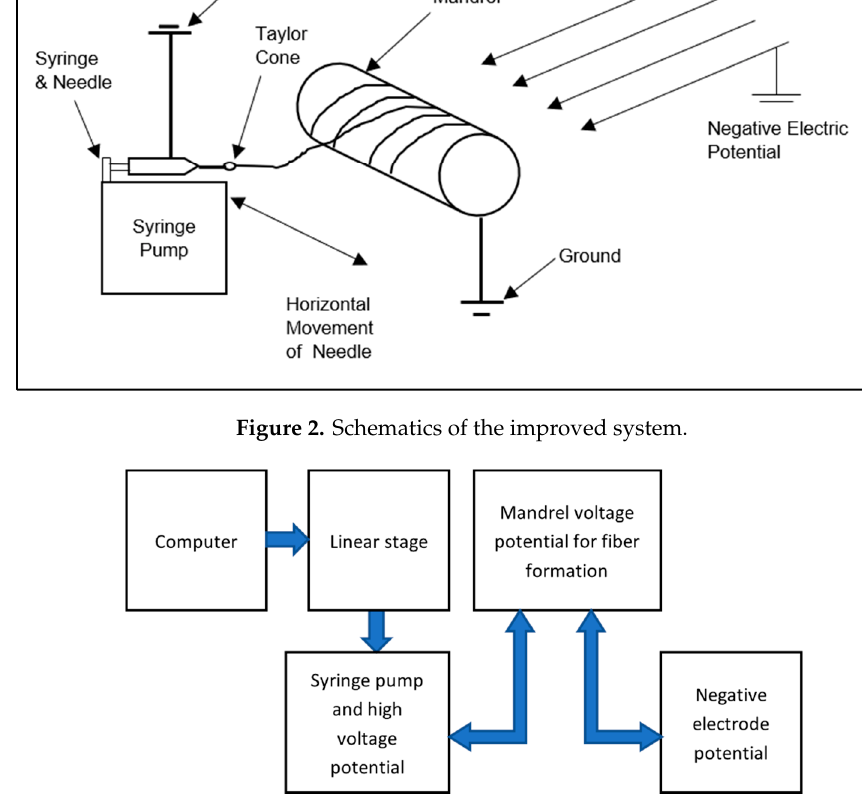
Figure 3. Flow chart of the improved system.